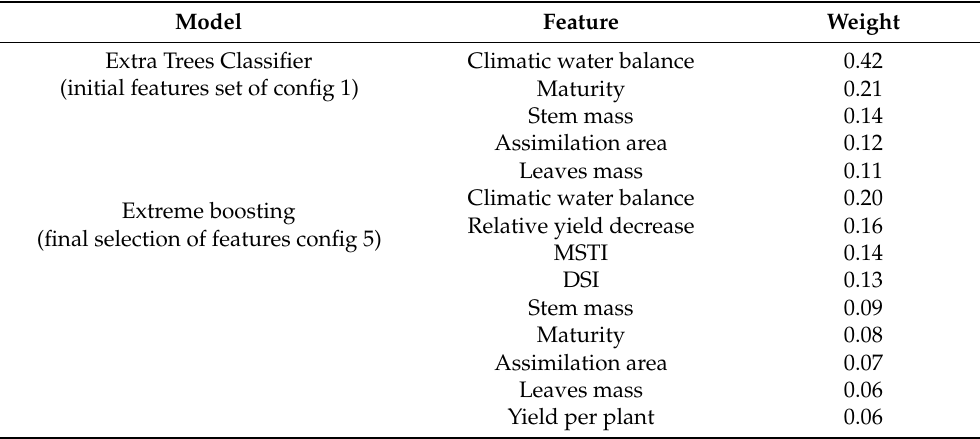
Table 6. The importance of the model features for two selected resistance models, the initial extra trees classifier and the finally selected extreme boosting